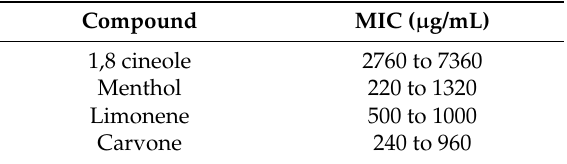
Table 3. Antifungal activity of main compounds of Mentha spp. Eos.